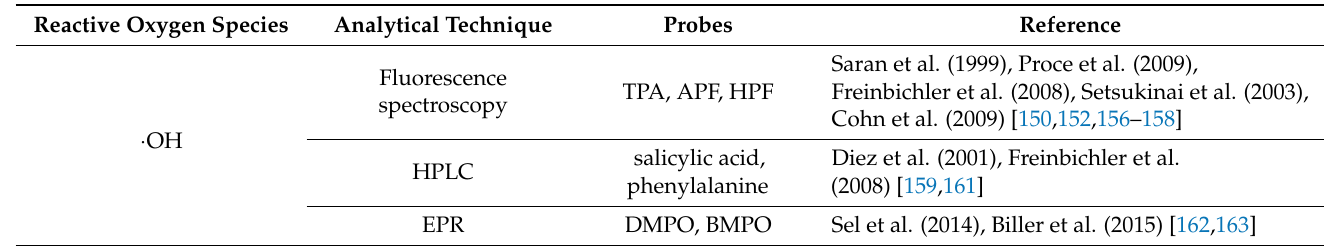
Table 4. Analytical techniques/assays to detect hydroxyl radicals with the corresponding probes and relevant